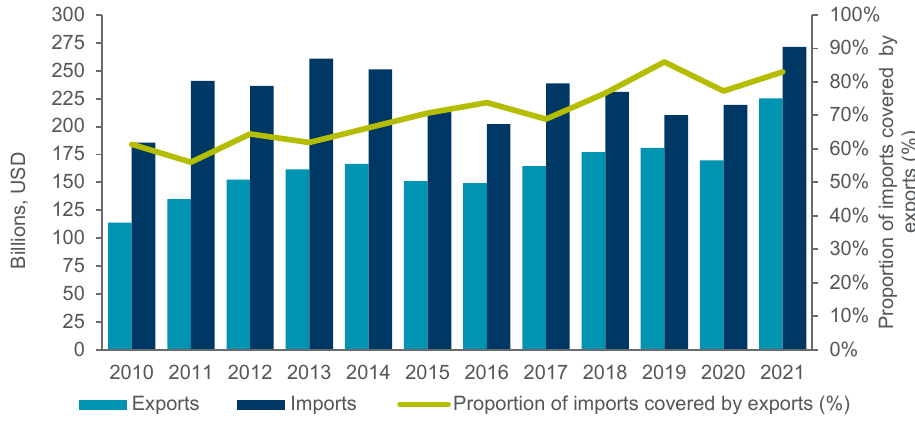
Figure 4 Foreign Trade (2010-2021), TURKSTAT,